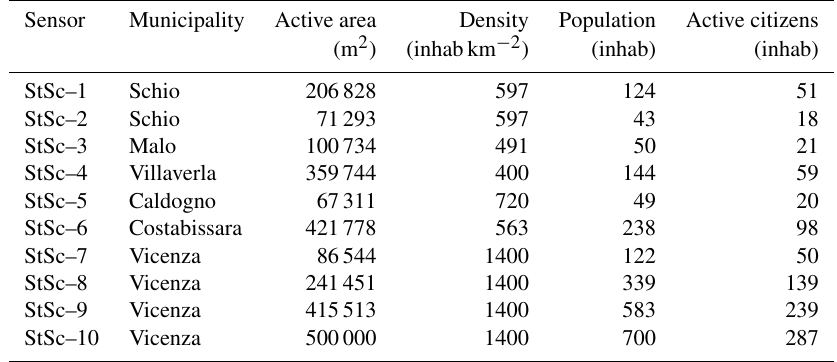
Table 4. Estimate of the active population that potentially can provide CS observations of W L with StSc